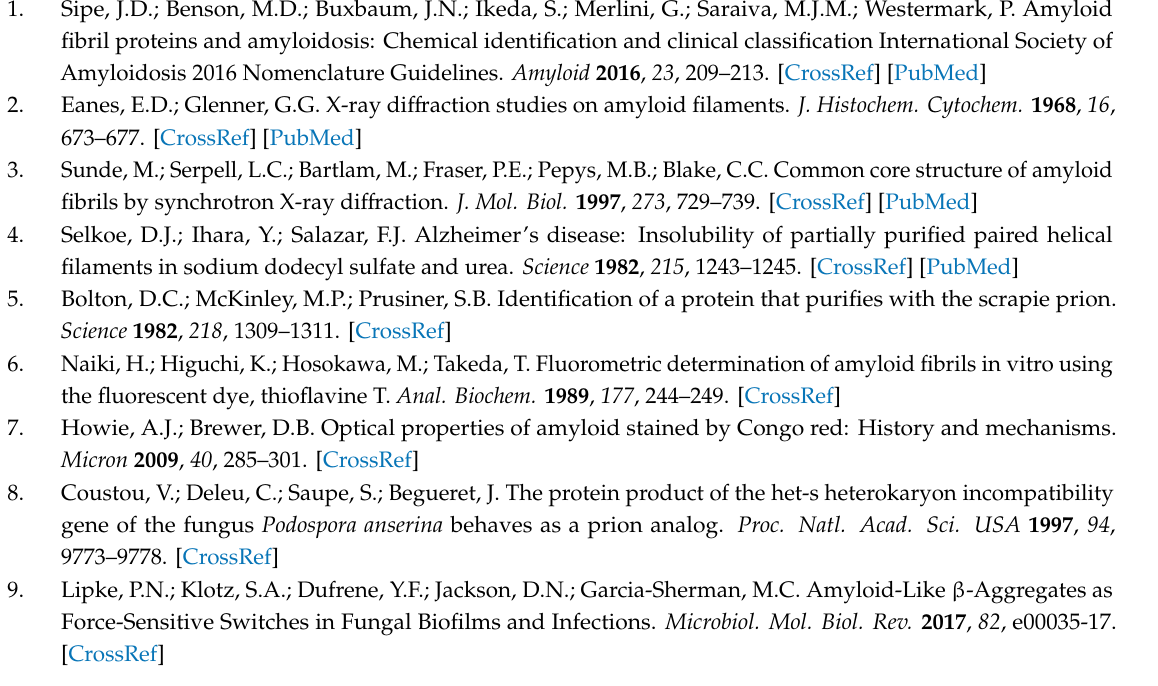
Figure S2 : Secondary structure of RopA and RopB in monomeric and aggregated states; Figure S3 : Fluorescence of ThT bound to RopA and RopB in monomeric and aggregated states; Figure S4 : Polarization microscopy of the CR-stained Sup35NM and Sup35M samples; Figure S5 : Analysis of the protease resistance of the Sup35NM protein obtained in vitro at the initial point of incubation by Western